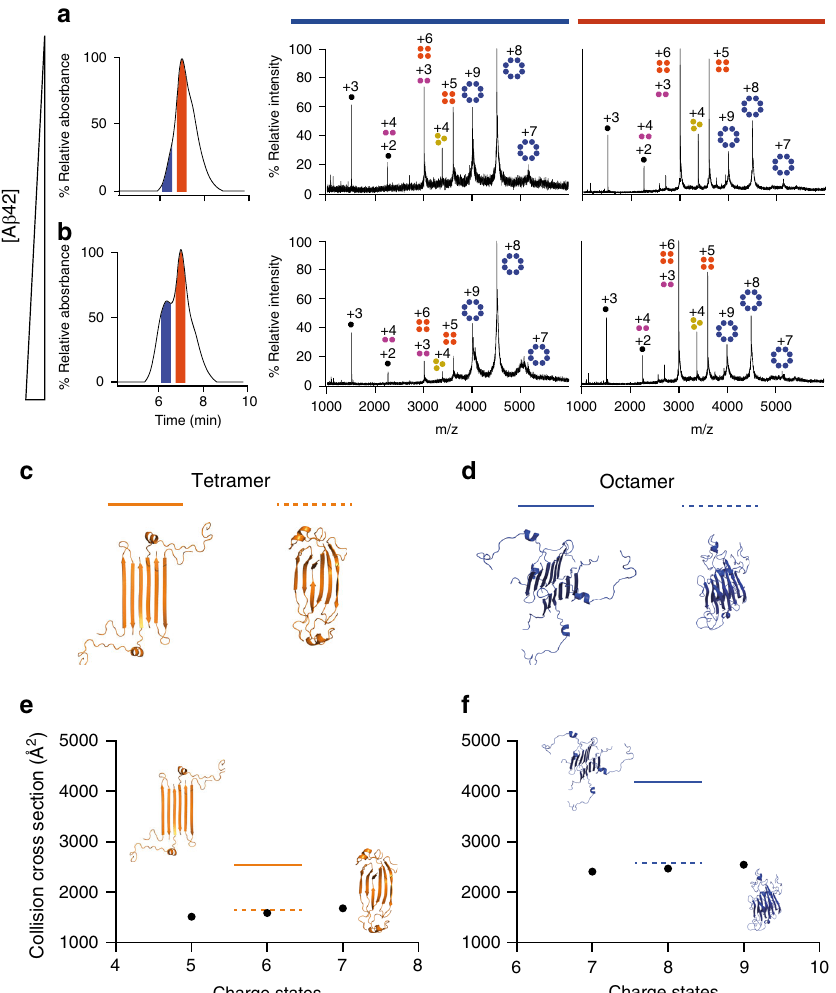
Fig. 4 A β (1-42) octamers adopt a β -sandwich structure. SEC-MS analysis of β PFOs A β (1-42) prepared at low ( a ) and high ( b ) A β (1-42) concentration. To couple SEC to MS analysis, the SEC column was equilibrated in C8E5. The mass spectra extracted from the blue and orange SEC peaks are shown, respectively, with a blue and orange line on top of them. The charge states corresponding to monomers, dimers, trimers, tetramers, and octamers are indicated with schematic drawings and labeled, respectively, in black, pink, yellow, orange and blue. c A β (1-42) tetramer structure derived from NMR restraints before (solid orange line) and after gas phase simulation for 100 ns prior to CCS calculation (dashed orange line). d β -sandwich octamer model based on the interaction of two A β (1-42) tetramers before (solid blue line) after gas phase simulation for 100 ns prior to CCS calculation (dashed blue line). e Experimental CCS of the tetramer (black dots) compared to the theoretical CCS of the A β (1-42) tetramer structure before (solid orange line) and after gas phase simulation for 100 ns prior to CCS calculation (dashed orange line). f Experimental CCS of the octamer (black dots) compared to the theoretical CCS of the β -sandwich structure before (solid blue line) and after gas phase simulation for 100 ns prior to CCS calculation (dashed blue line). Source data are provided as a Source data fi